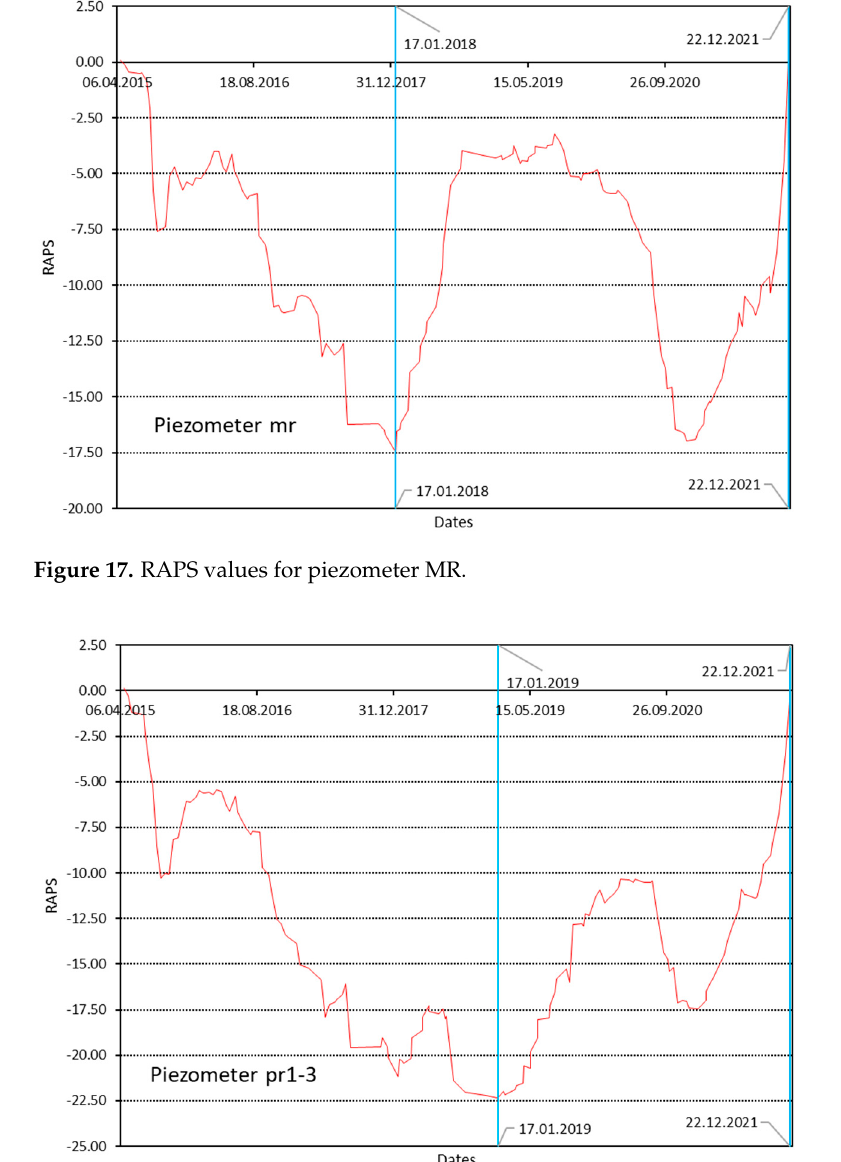
Figure 18. RAPS values for piezometer PR1/3.